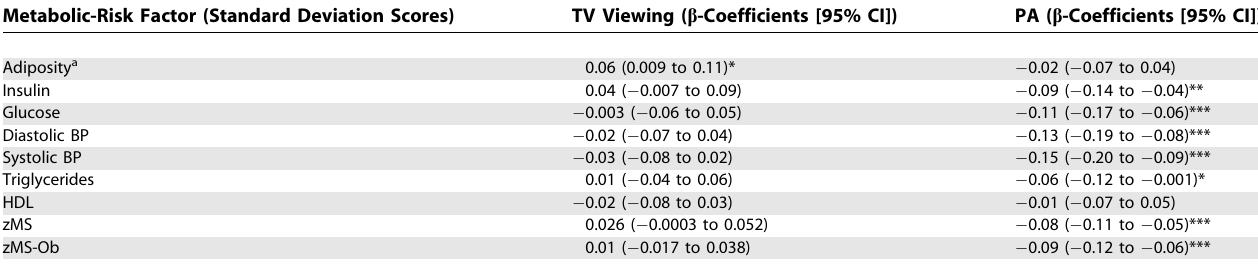
Table 3. Independent Associations of TV Viewing and of Objectively Measured PA, with Individual and Clustered Metabolic-Risk Factors with zMS and with zMS-Ob